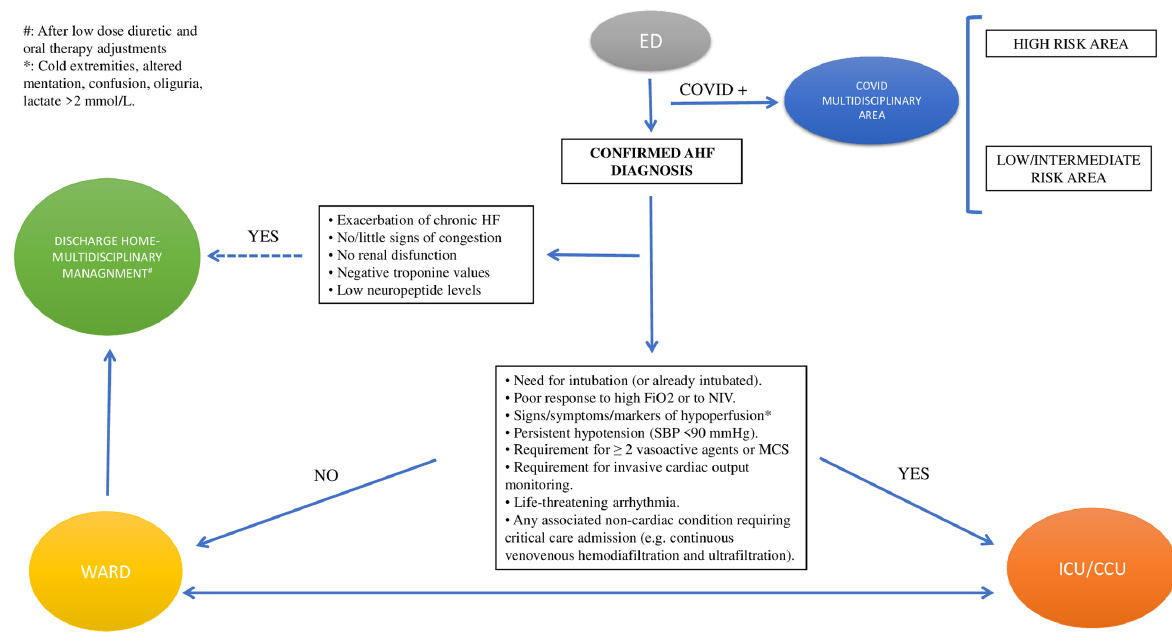
Figure 1. Triage. Abbreviations: AHF: acute heart failure; ED: emergency department; ICU/CCU: intensive cardiology unit/critical care unit; MCS: mechanical circulatory support; NIV: non-invasive ventilation; SBP: systolic blood pressure.